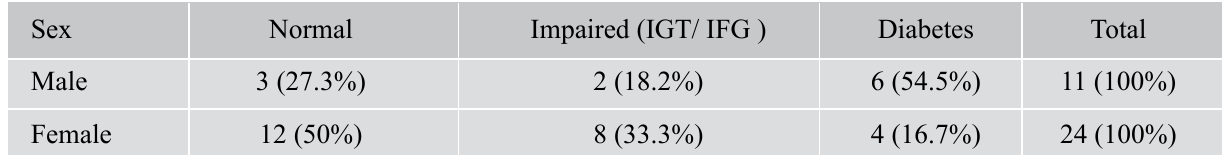
Table III: Pattern of glucose homeostasis in male and female